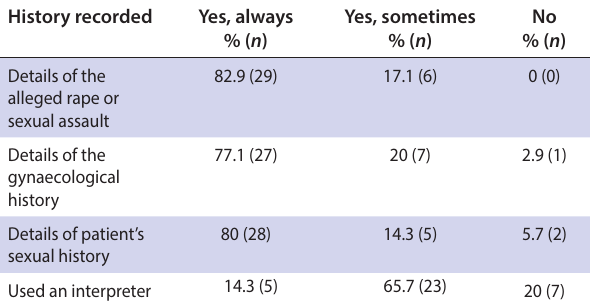
Table 2: Recording detailed histories of patients who alleged being raped ( n =